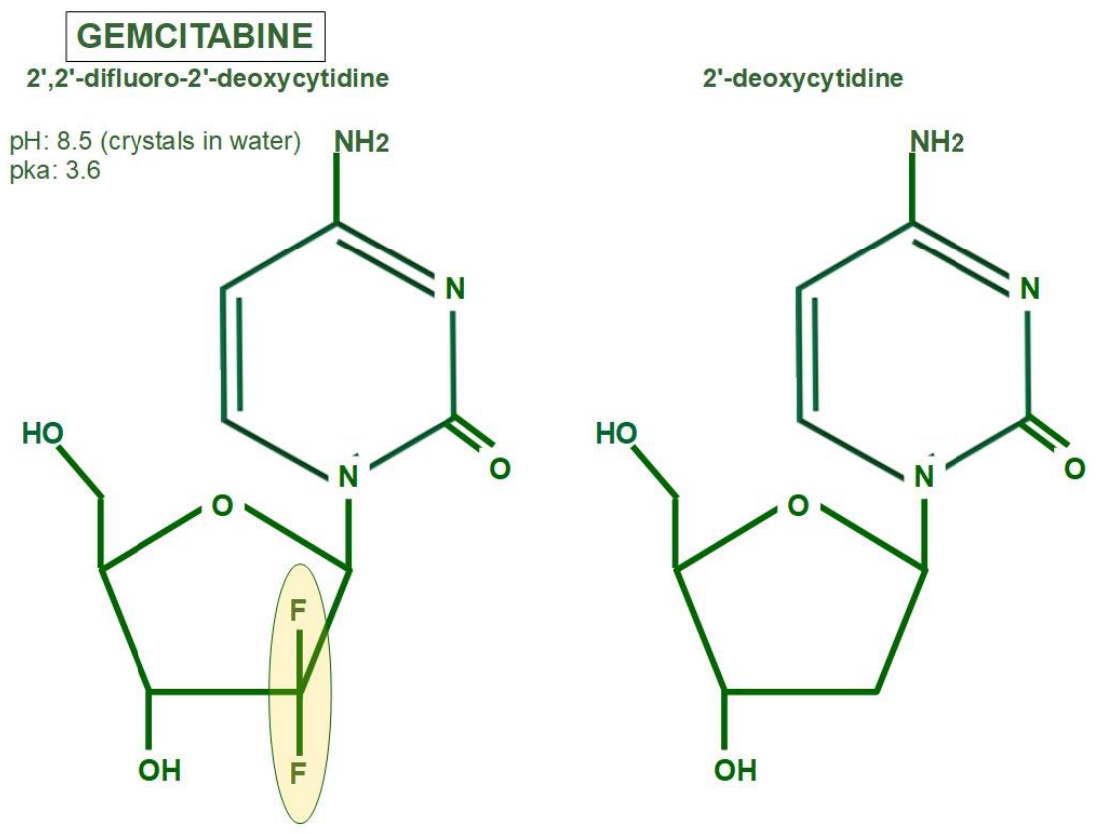
Figure 2. Gemcitabine chemical formula [222] on the left side. The right side shows 2-deoxycytidine (cytosine deoxyribonucleoside), the nucleosidewhich gemcitabine competes against. Cytosine de- oxyribonucleoside is one of the four nucleosides that form part of DNA.